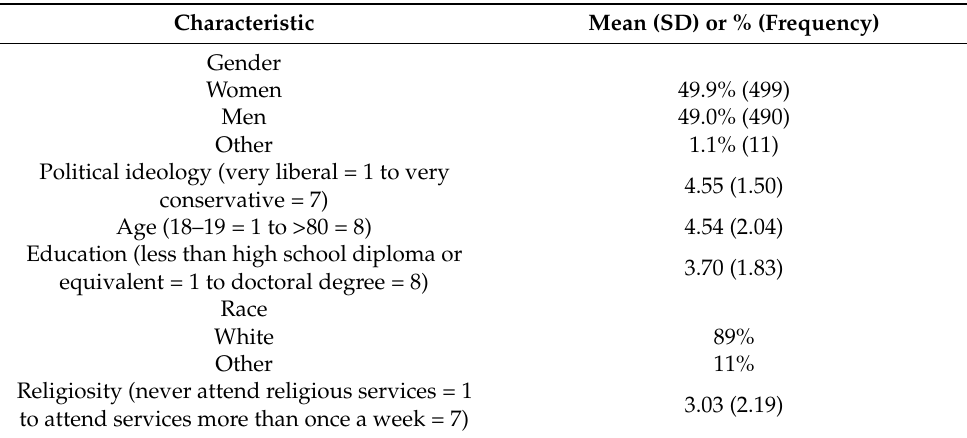
Table 2. Sample Characteristics 1